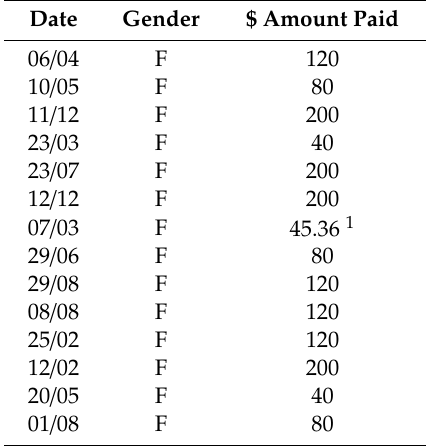
Table 2. Successful applications for Dependent Care Support, January 2018–August 2019.